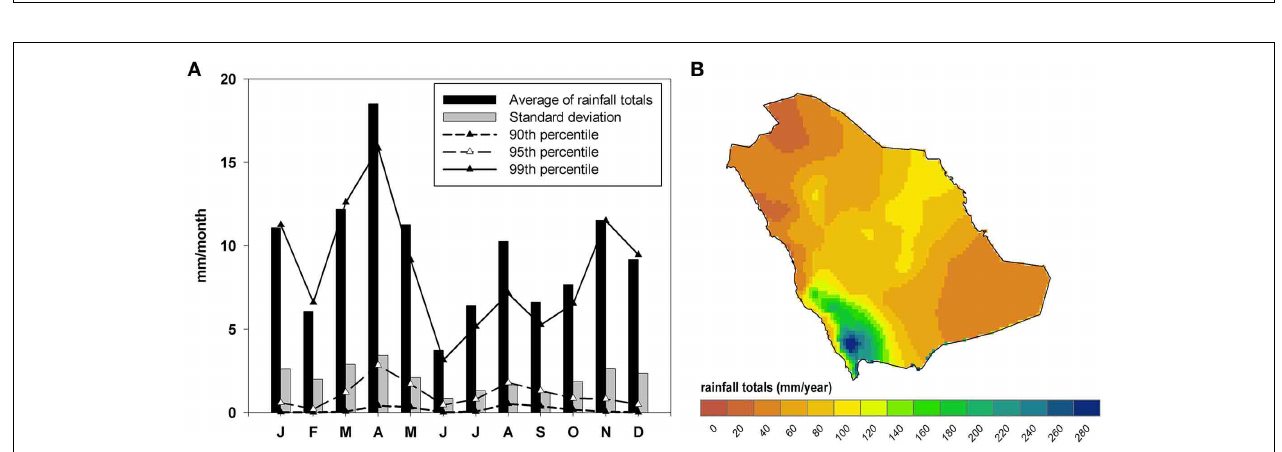
FIGURE 1 | Location of the study domain and the spatial distribution of the meteorological stations together with the 16 grid points (1–16) used in the automated circulation-typing.